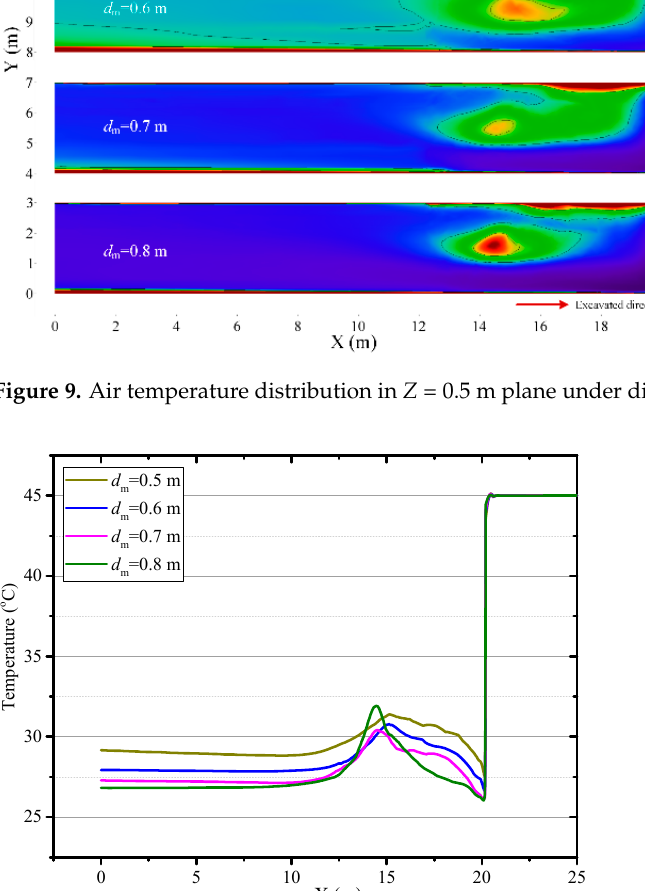
Figure 10. Air temperature in central axis of roadway ( Z = 0.5 m) under different diameter of air duct .